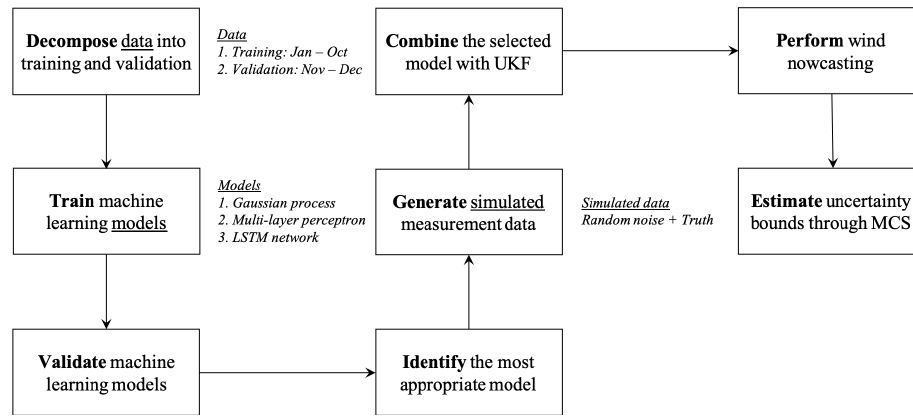
Figure 1. Overall flowchart of the proposed